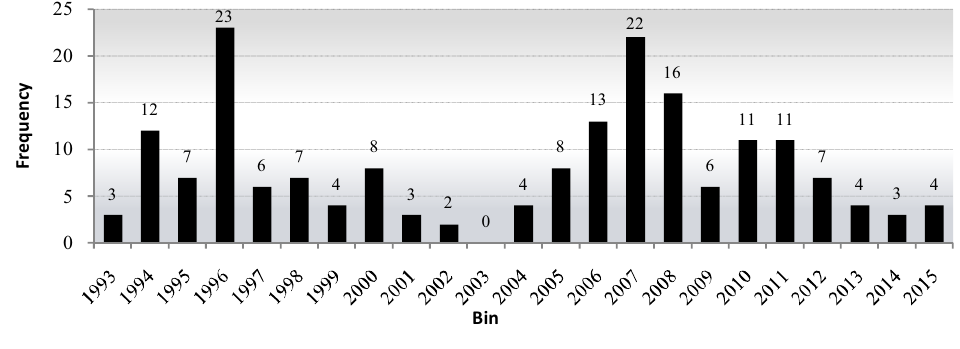
Fig. 1. Number of normal stock splits in V4 since 1993 to 2015